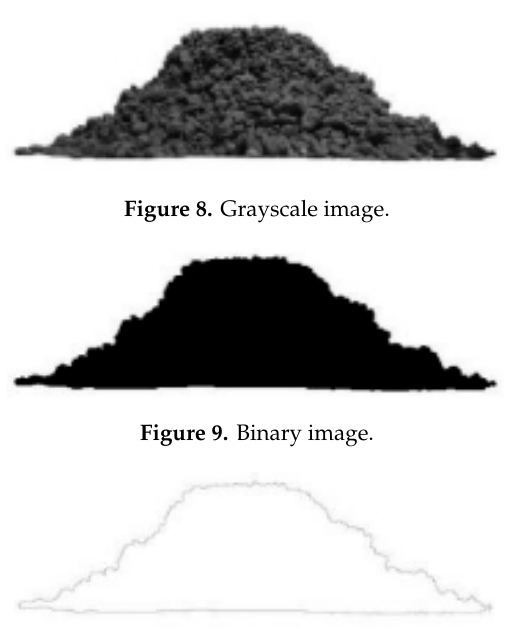
Figure 10. Contour curve of the accumulation body.